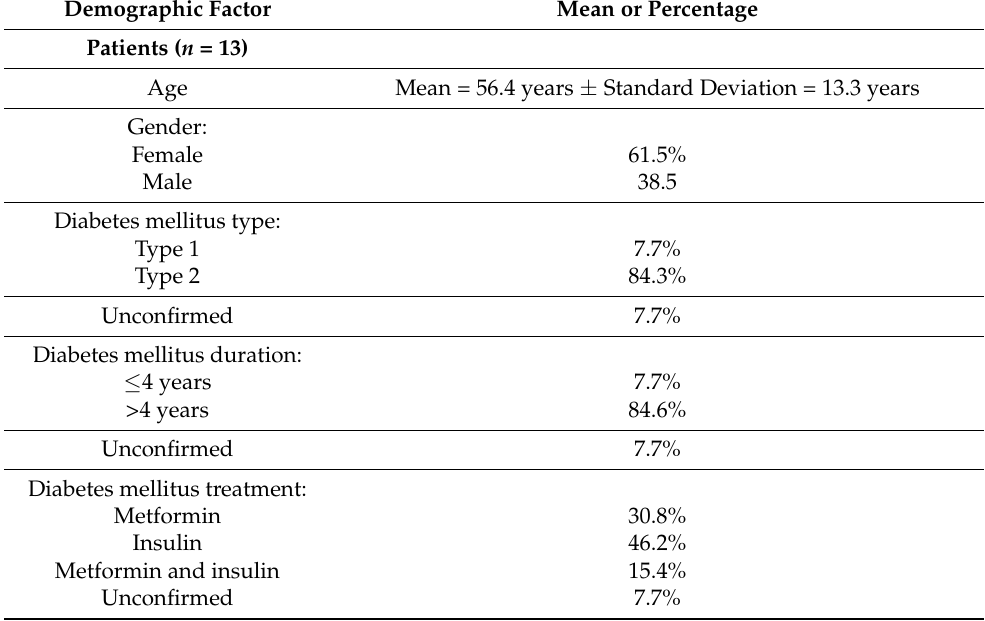
Table 1. The mean values for select patient demographic information, and best-corrected visual acuities, binocularly and